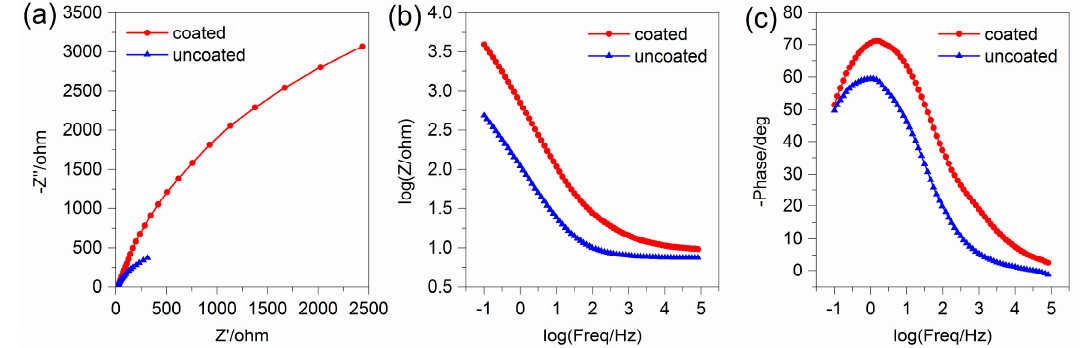
Figure 7. Impedance spectra of coated and uncoated specimens in 3.5% NaCl solution: ( a ) Nyquist curves; ( b ) Bode-impedance; ( c ) Bode-phase.